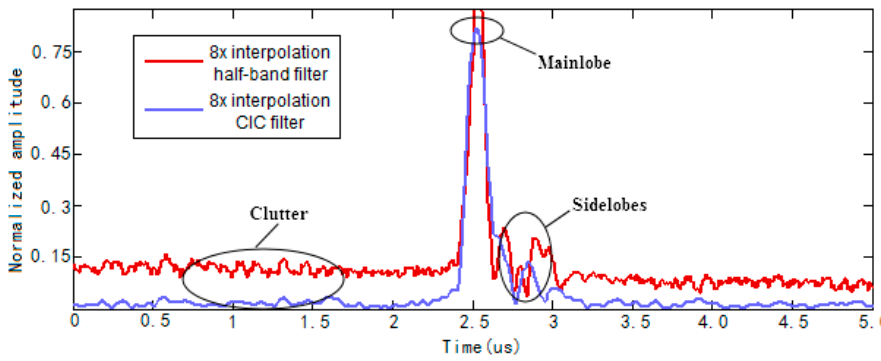
Figure 14. Envelope curves of synthesized A-scan defect echo signals.